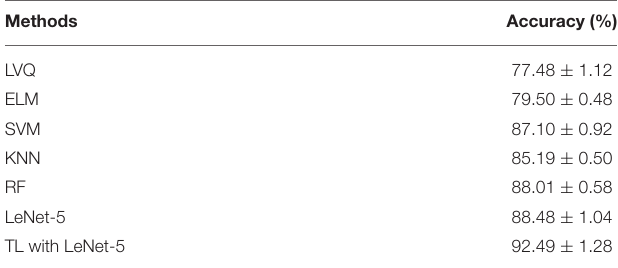
TABLE 4 | Diagnosis accuracy based on seven different methods under a complex environment.